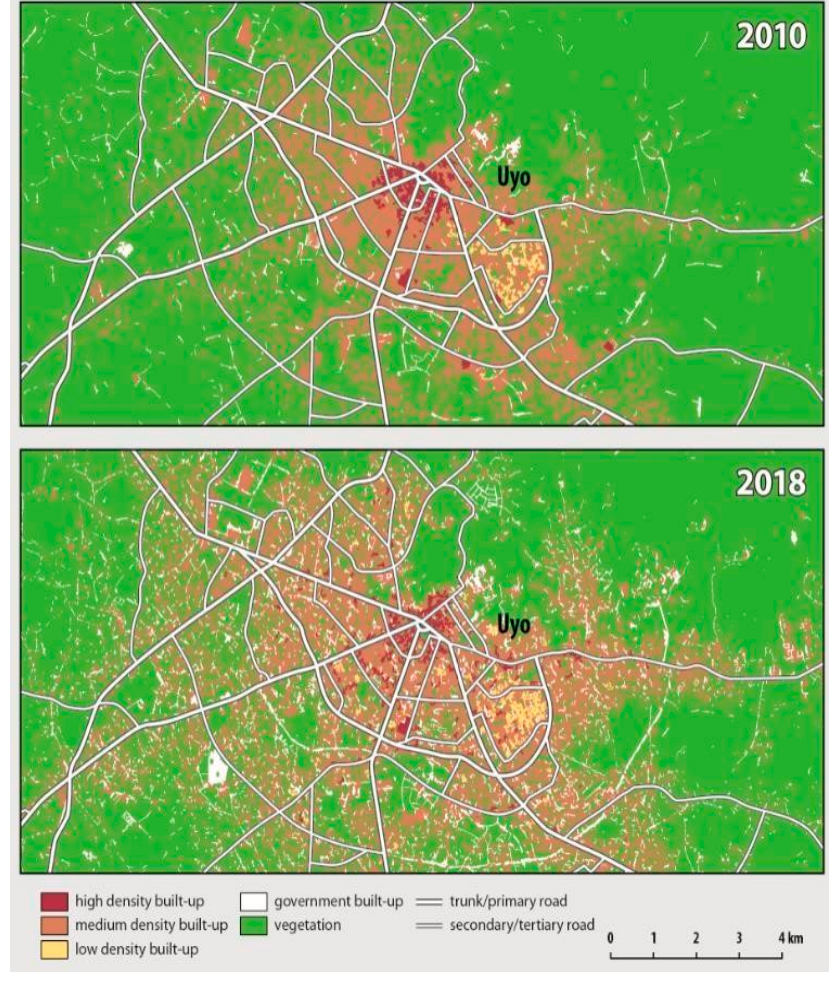
Figure 2. Urban land-use land cover changes in Uyo.